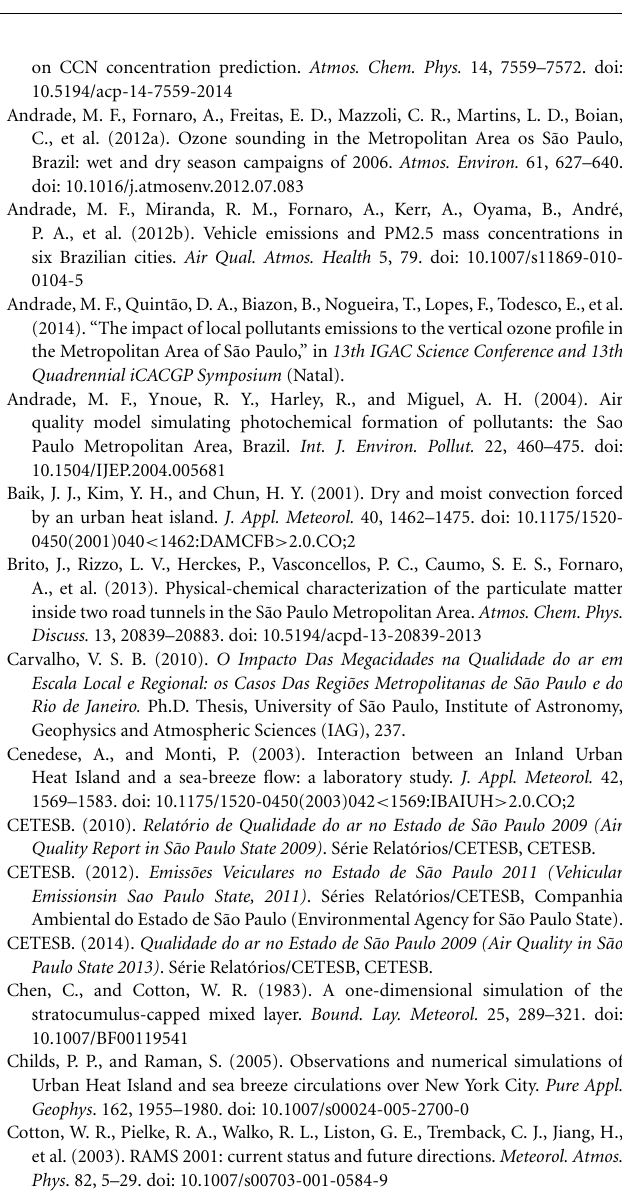
FIGURE 12 | Spatial distribution of industrial emissions of SO 2 (A) and vehicle emissions of CO (B) over the Metropolitan Area of Rio de Janeiro in 2007. Sources: Rio de Janeiro State Environmental Agency; Carvalho (2010).